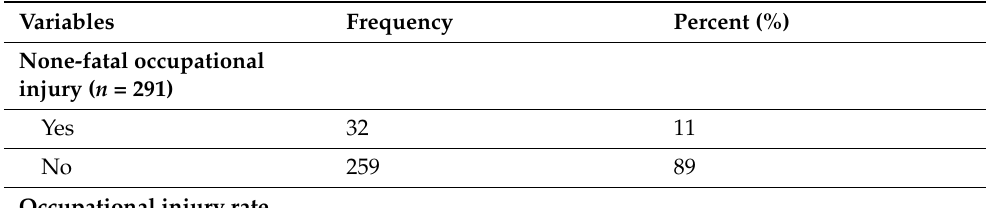
Table 4. Characteristics of injuries among integrated textile industry workers, Addis Ababa, Ethiopia, 2021.